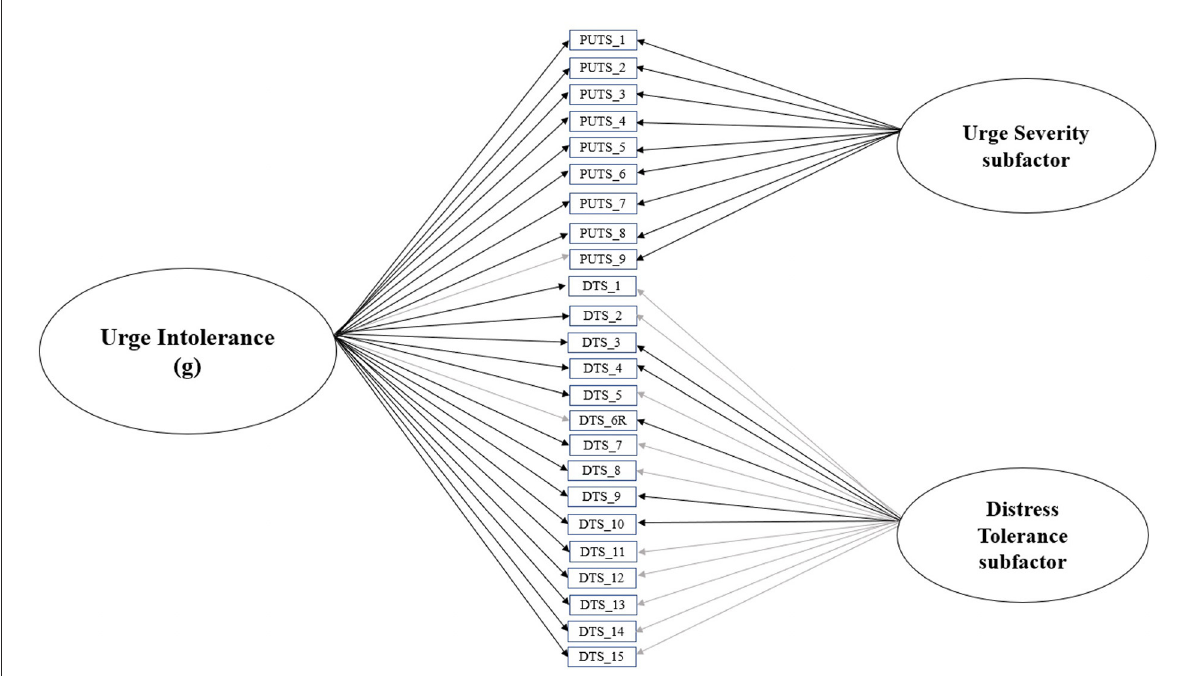
FIGURE1 Final bifactor model of urge intolerance, with urge severity and distress tolerance subfactors. Black lines indicate significant standardized item loadings, while gray lines indicate non-significant standardized item